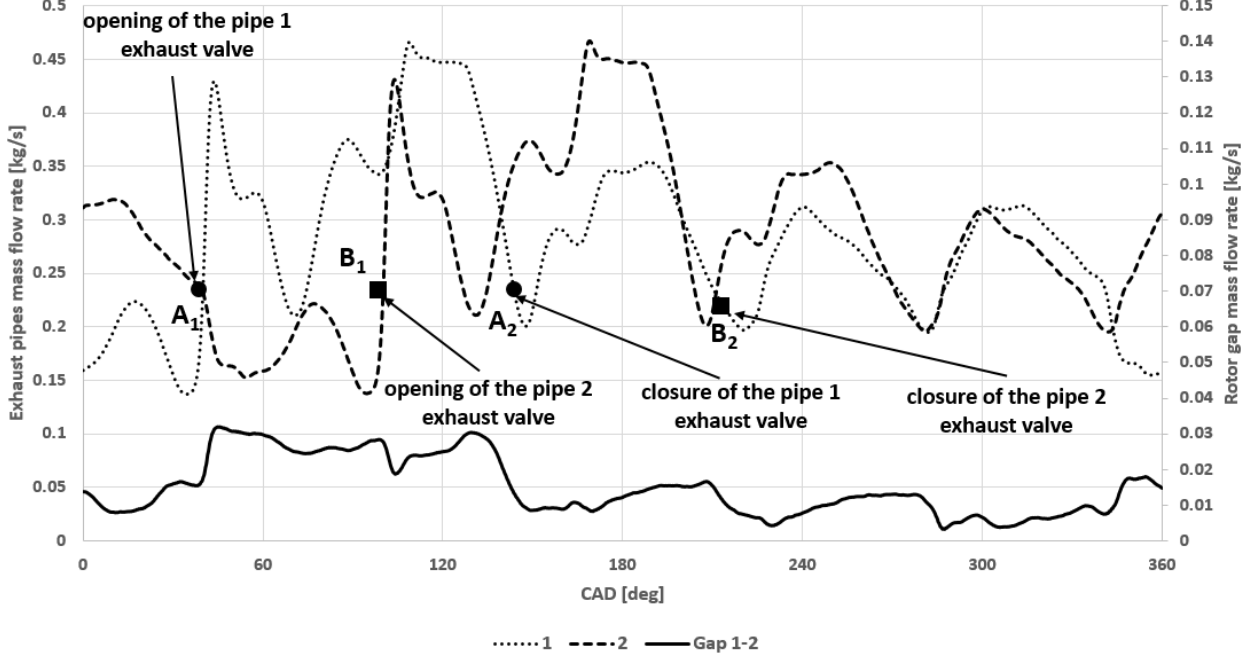
Figure 19. The variation of exhaust mass-flow rate at the inlet to the first-stage rotor from two adja- cent exhaust pipes no 1 and 2 and at the rotor gap between those pipes.